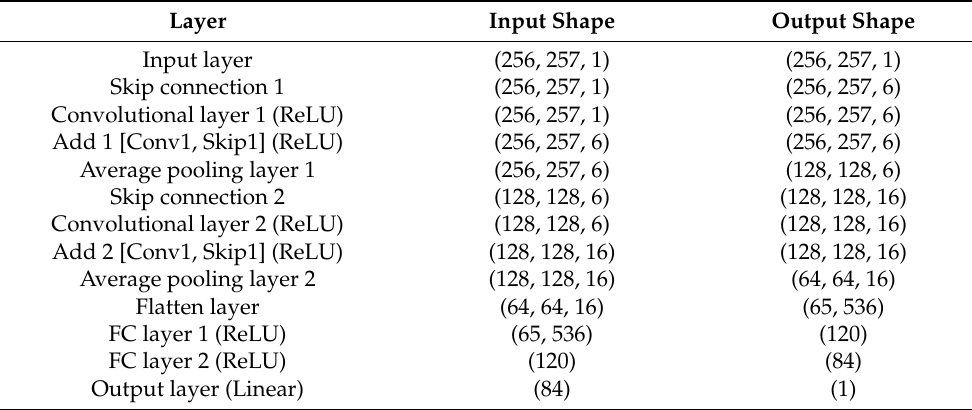
Table 2. Detailed architecture of proposed